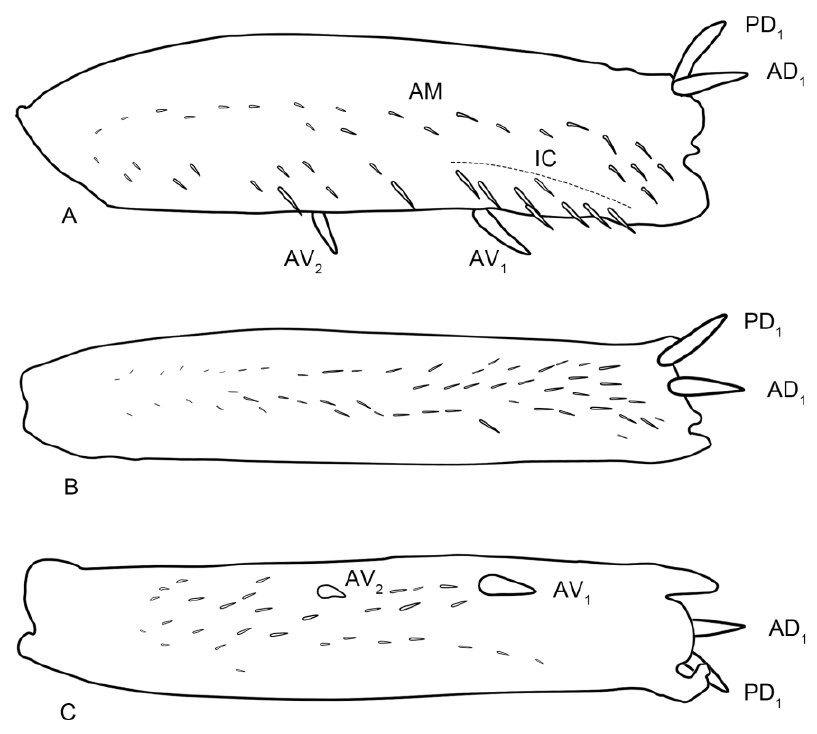
Figure 12. ( A – C ) The left forefemora of Planaphrodes bifasciatus . ( A ) anterior view. ( B ) dorsal view. ( C ) ventral view. AM = anteromedial row; IC = intercalary row; AV = anteroventral row; AD = anterodorsal row; PD = posterodorsal row.